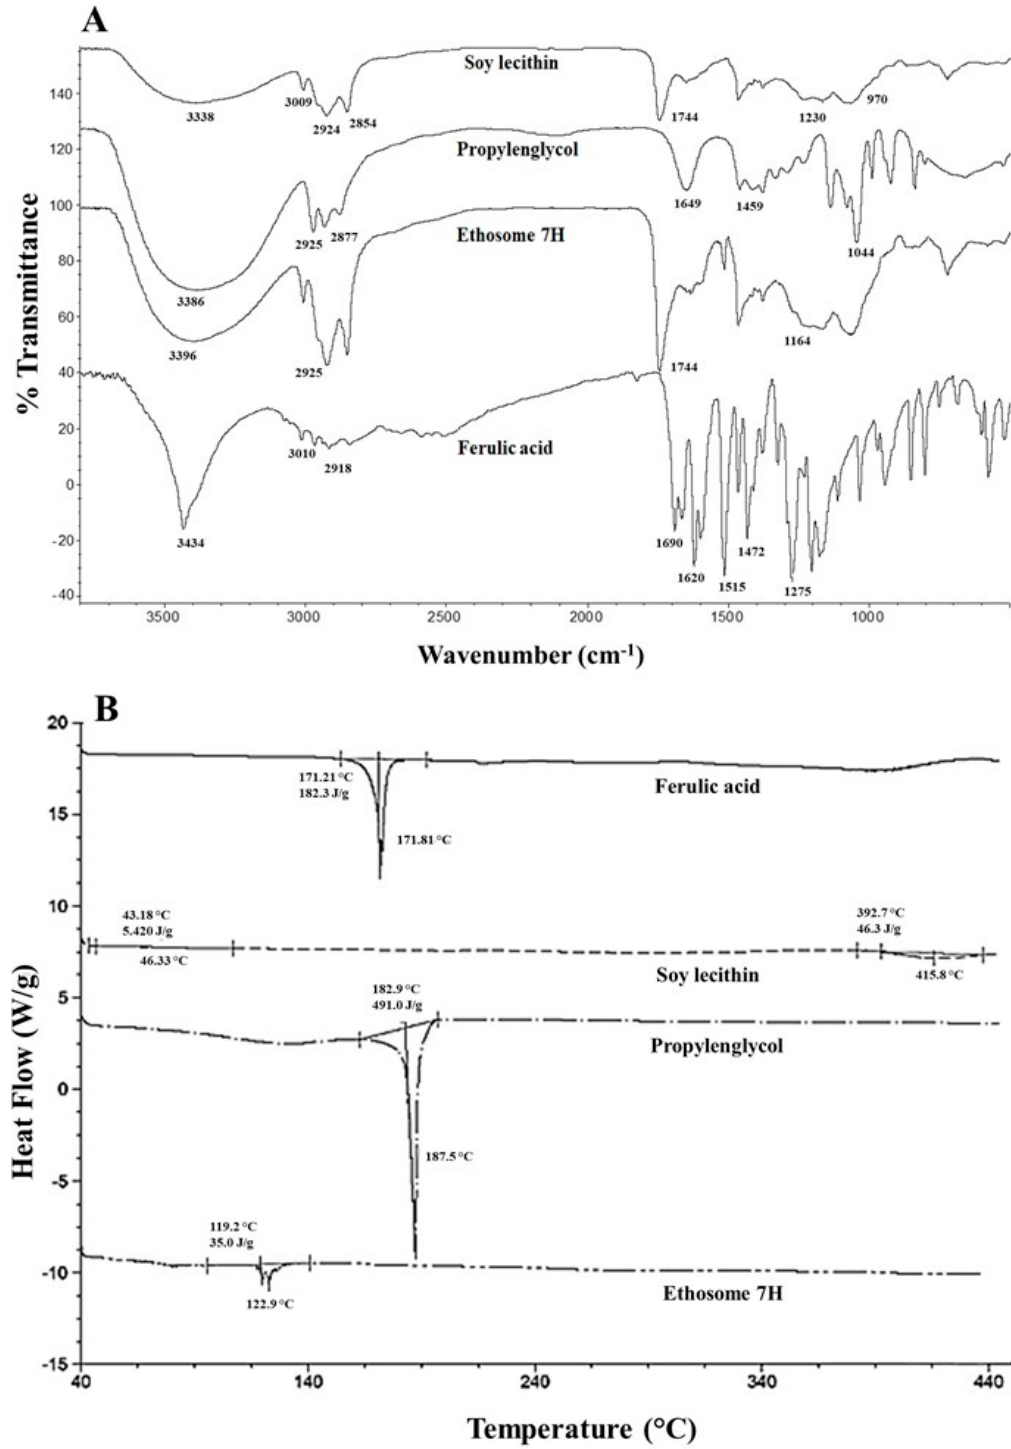
Figure 3. ( A ) FT-IR spectra and ( B ) DSC thermograms of FA, soy lecithin, propylene glycol, and ethosome samples.